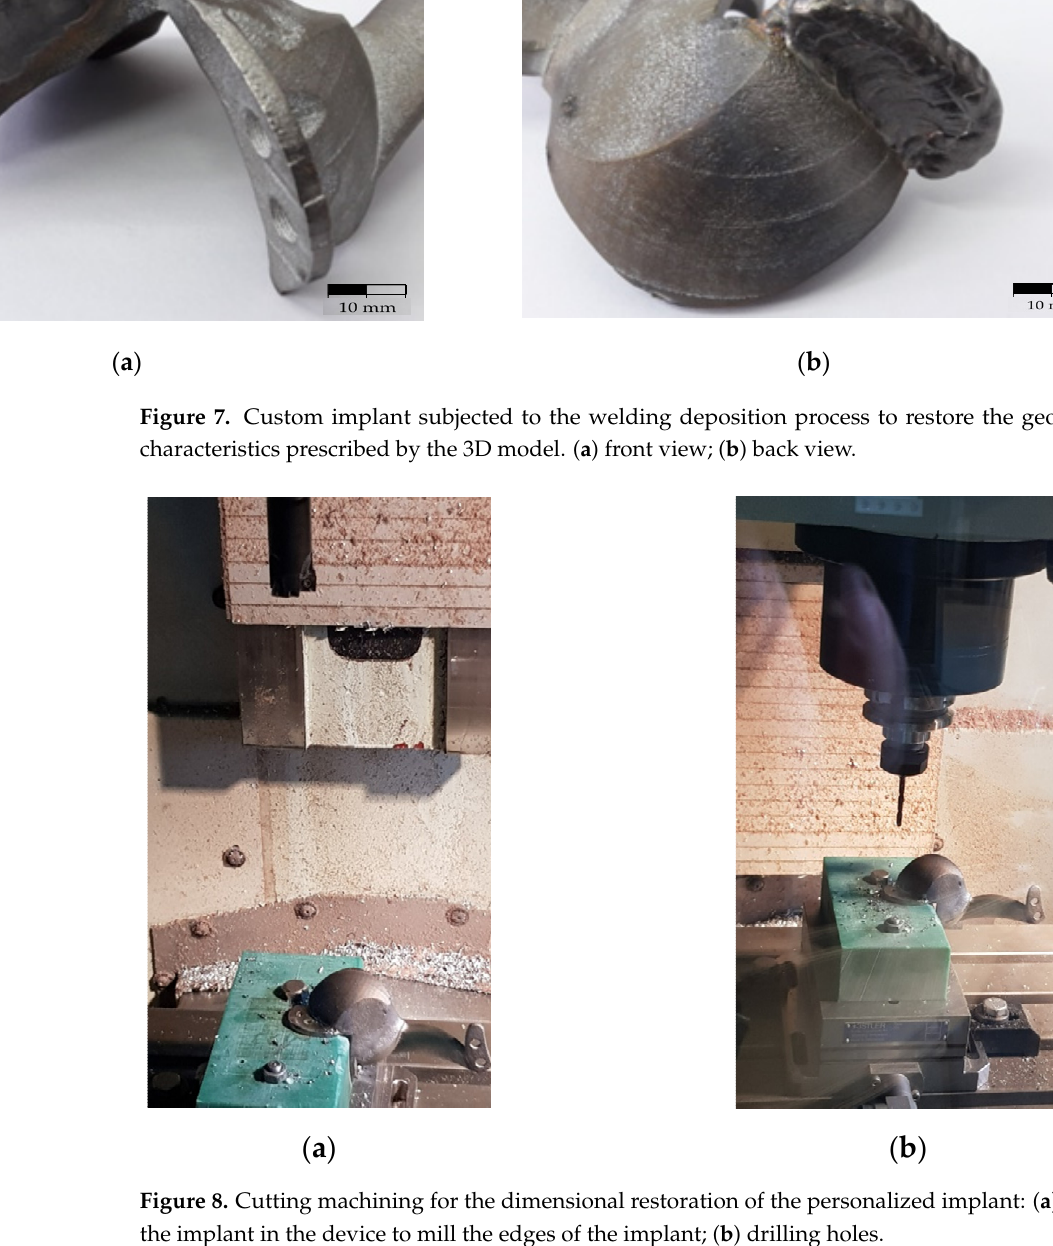
Figure 8. Cutting machining for the dimensional restoration of the personalized implant: ( a ) fixing the implant in the device to mill the edges of the implant; ( b ) drilling holes.